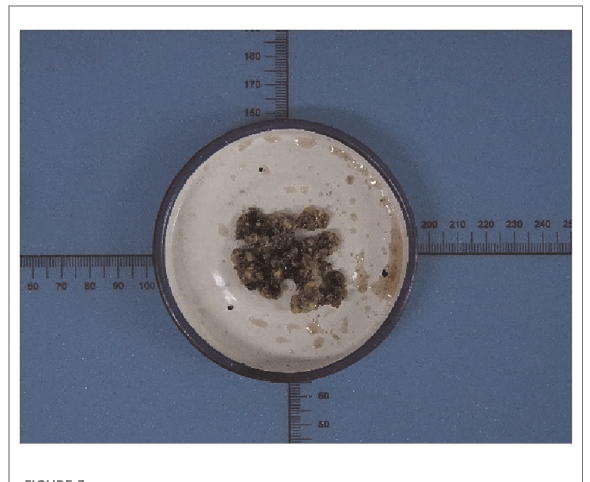
FIGURE 3 Histopathological examination of the specimens revealed that a pile of yellow broken bone tissues were visible to the naked eye.